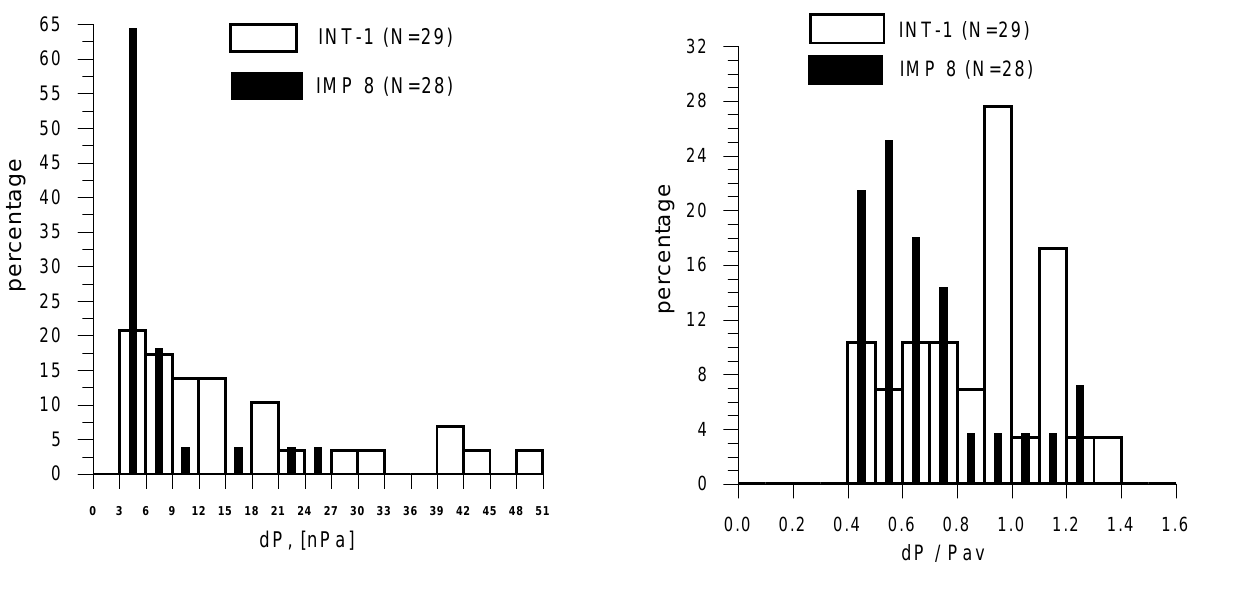
Fig. 6. Distributions of dP for the largest events. Fig. 7. Distributions of dP/P av for the largest